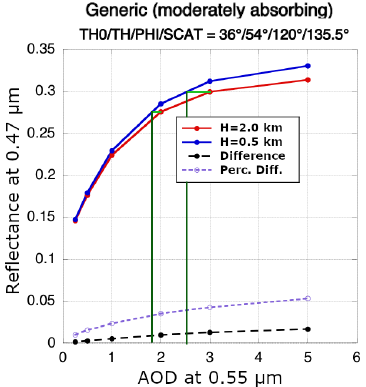
Figure 7. Top-of-atmosphere reflectance at 0.47µm correspond- ing to AOD at 0.55µm using the moderately absorbing model for the specific geometry of solar zenith angle = 36 ◦ , view zenith angle = 54 ◦ , relative azimuth angle = 120 ◦ , and scattering an- gle = 135.5 ◦ . The red and blue lines are the calculated TOA re- flectance at aerosol scale heights of 2.0 and 0.5km, respectively. The dashed black and purple lines are the differences between the red and blue lines and the percentage differences. The horizontal light-green line segments indicate TOA reflectance when AOD is 2 and 3 using a scale height of 2.0km. The corresponding verti- cal dark-green lines are corresponding AOD using a scale height of